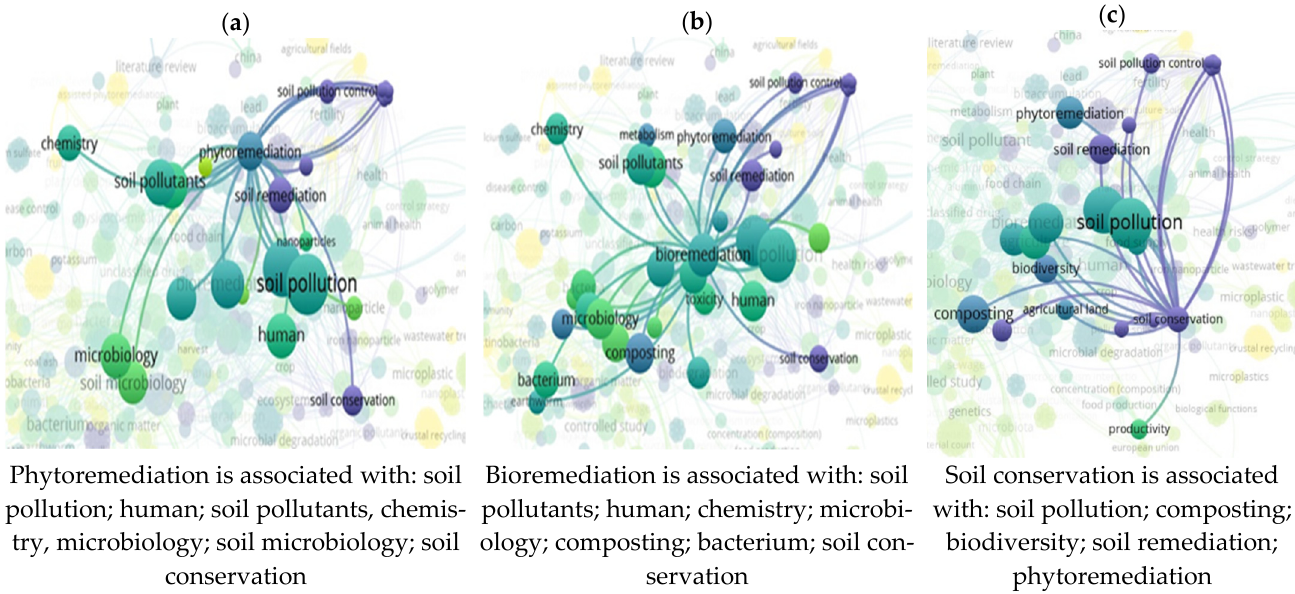
Figure 9. Analyzing Scopus results with the VOSviewer. Phytoremediation ( a ), bioremediation ( b ) and soil conservation ( c ) paradigm.